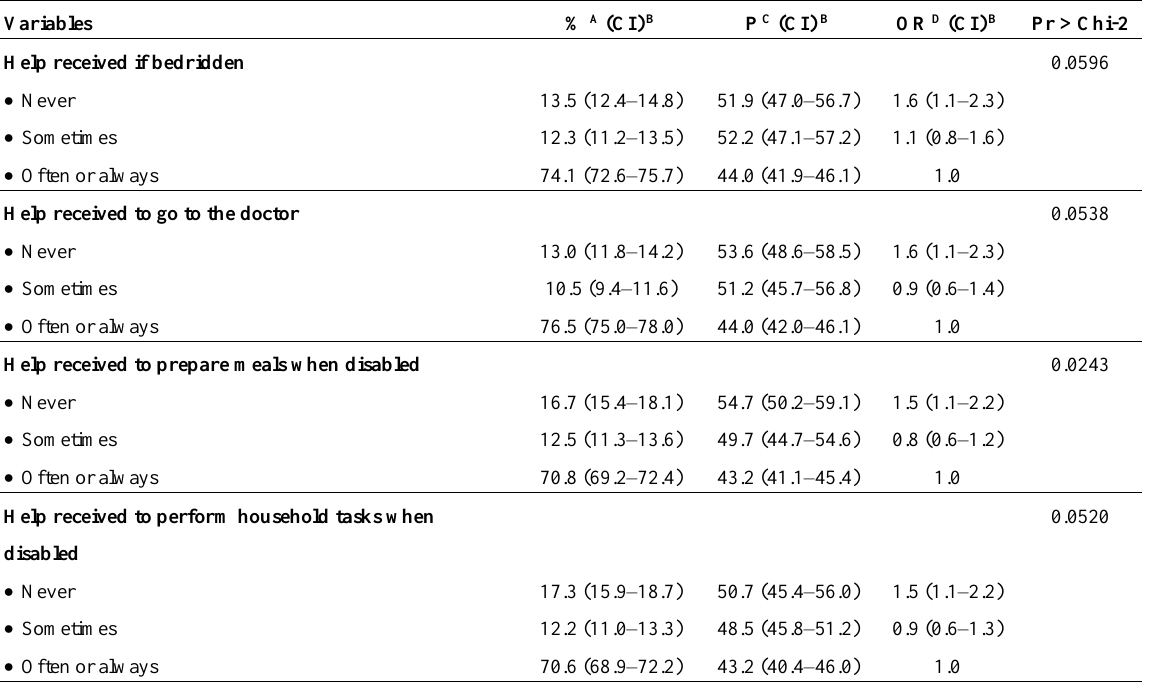
Table 6. Prevalence of reported adverse health impacts, very hot and humid summer conditions, based on support and social